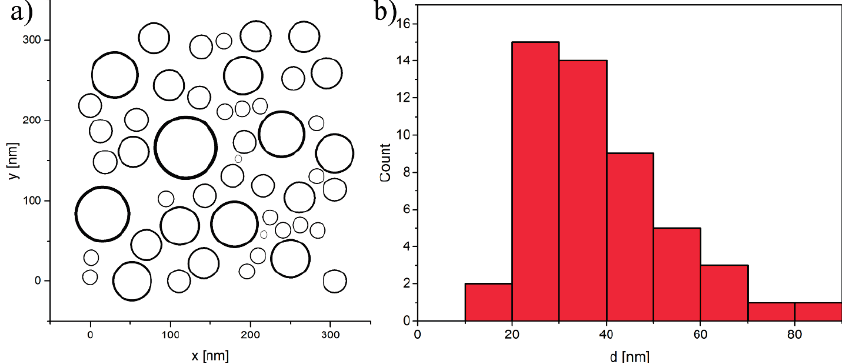
Figure 5. Model structure consisting of 50 cobalt nanoparticles with diameters in the range between 10 nm and 80 nm ( a ). The particles are distributed over an area of 350 nm × 350 nm. The size distribution ( b ) is taken from experimental studies on particle-based GMR sensors